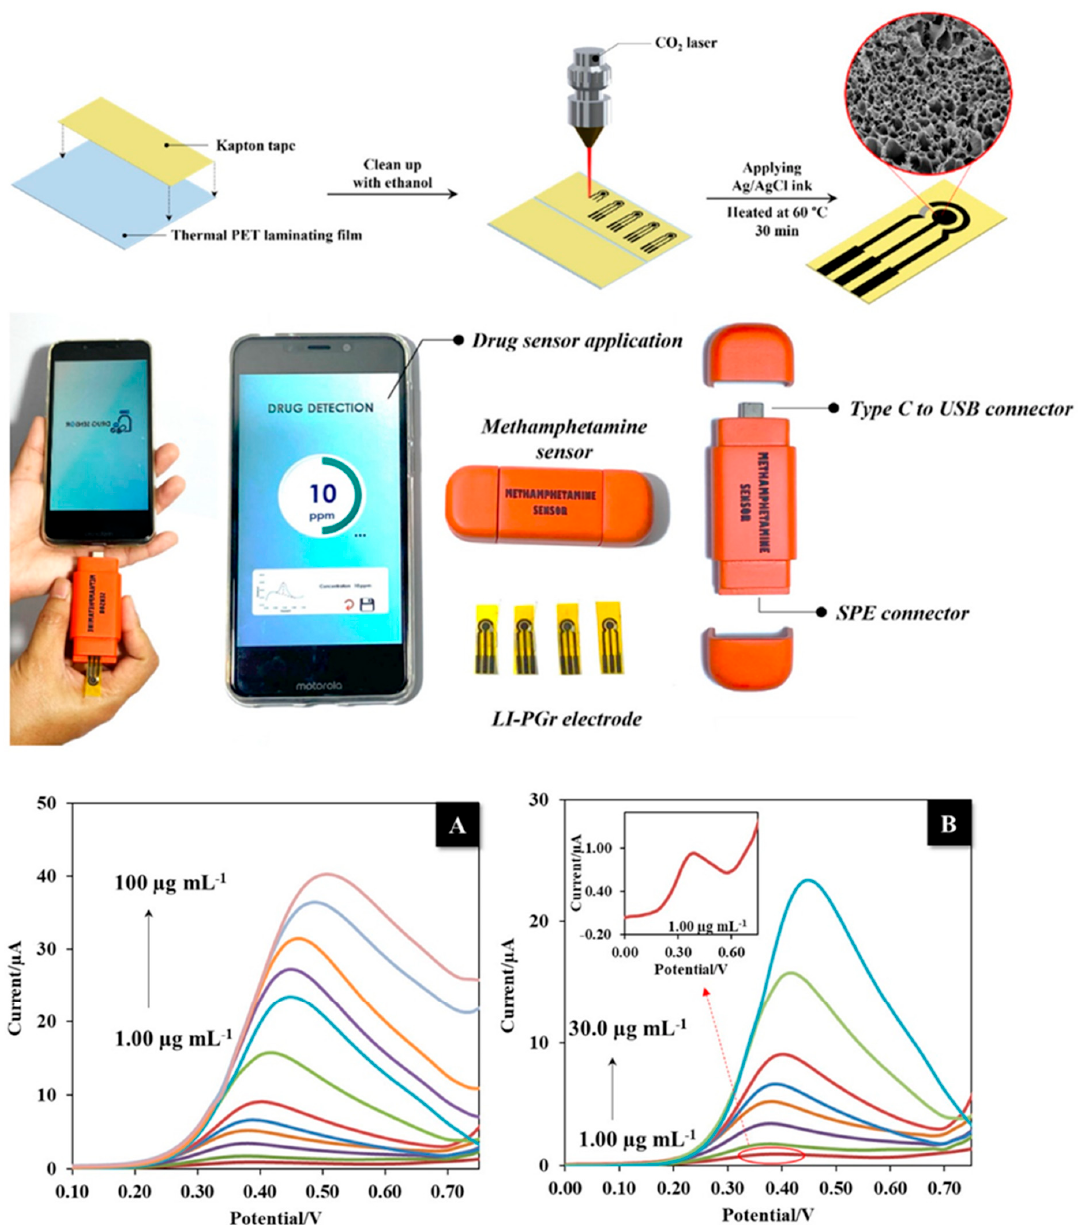
Figure 5. Schematic representation of the laser-induced porous graphene electrode fabrication and the components of the developed portable methamphetamine sensor illustrated at the top of the figure. ( A , B ) show the analytical characteristics of the sensor: ( A ) DPV responses of MA in the developed portable device. ( B ) DPV responses of MA, while showing inset—amplified anodic peak current of MA at a concentration of 1.00 µ g mL − 1 . Adapted with permission from ref. [93]. Copyright 2022 MDPI.